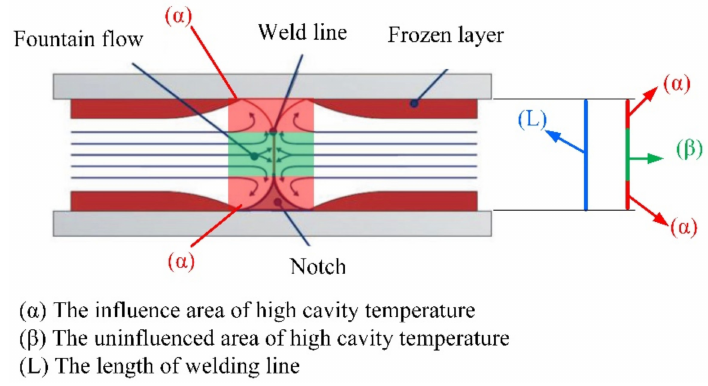
Figure 21. The influence area of high cavity temperature